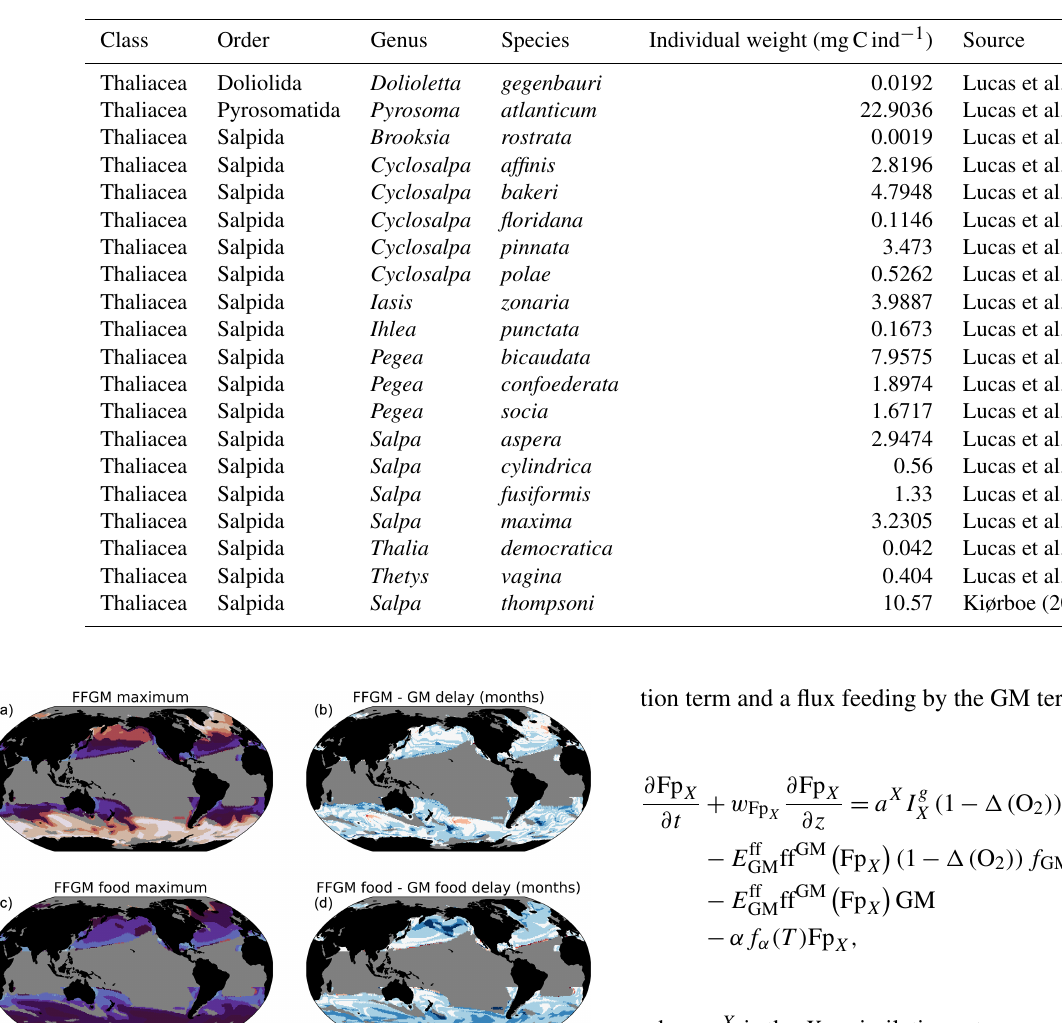
Table A1. Table of individual weights used for abundance-to-biomass conversions For Salpa thompsoni , we computed the mean of the corresponding mass measurements of individual zooplankters in Table A1 of Kiørboe (2013). For all the other species, we used values from Appendix A4 from Lucas et al. (2014).